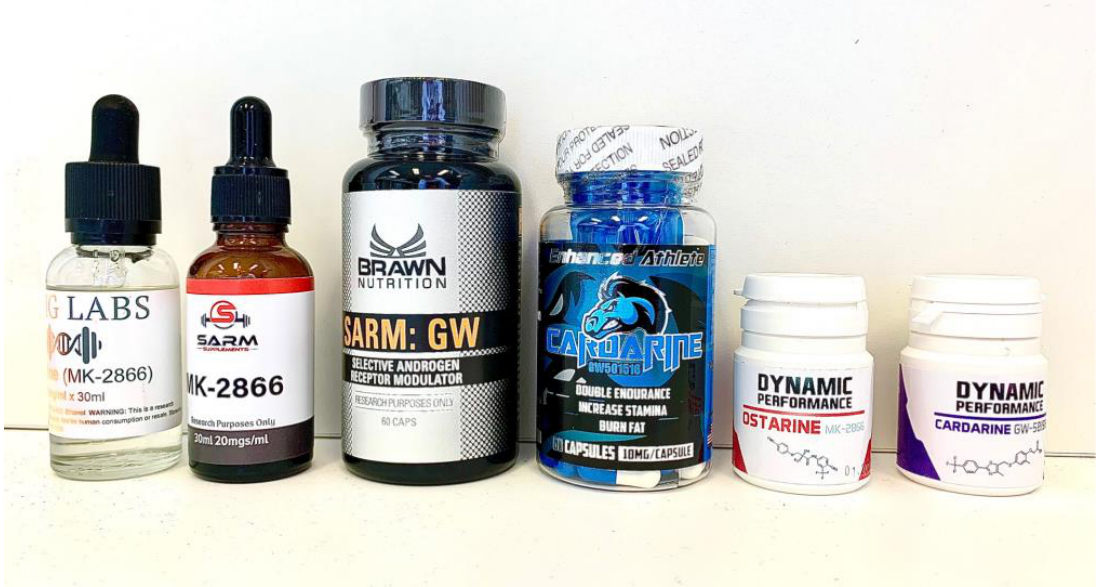
Figure 1. Typical material sold on the Internet.